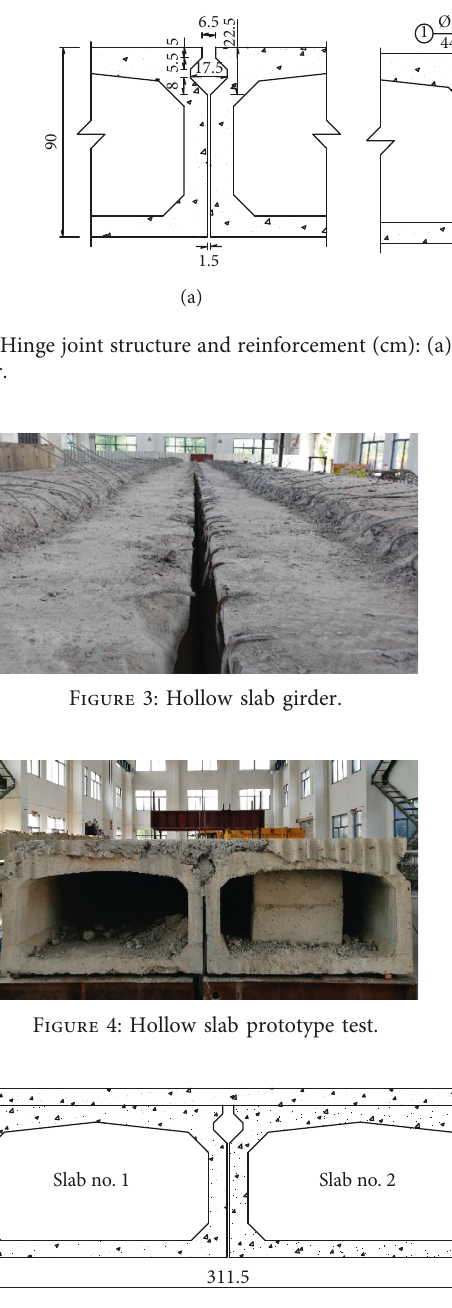
Figure 5: Cross section of a hollow slab (cm).